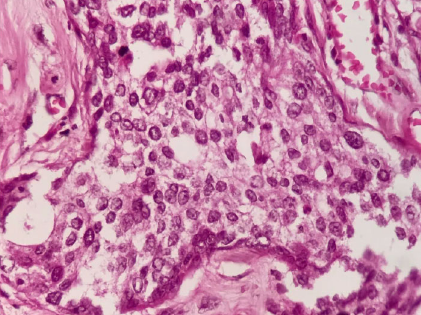
Figure 4: high magni fi cation HEx40, polygonal tumor cells with moderately atypical nuclei and abundant eosinophilic cytoplasm.